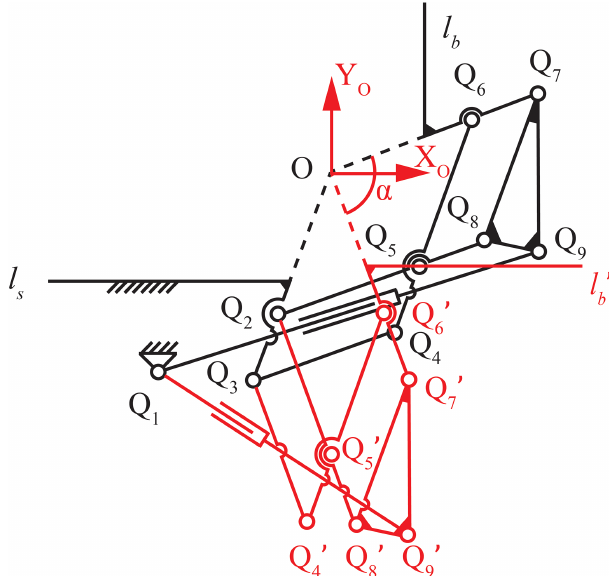
Figure 10. Schematic diagram of the back